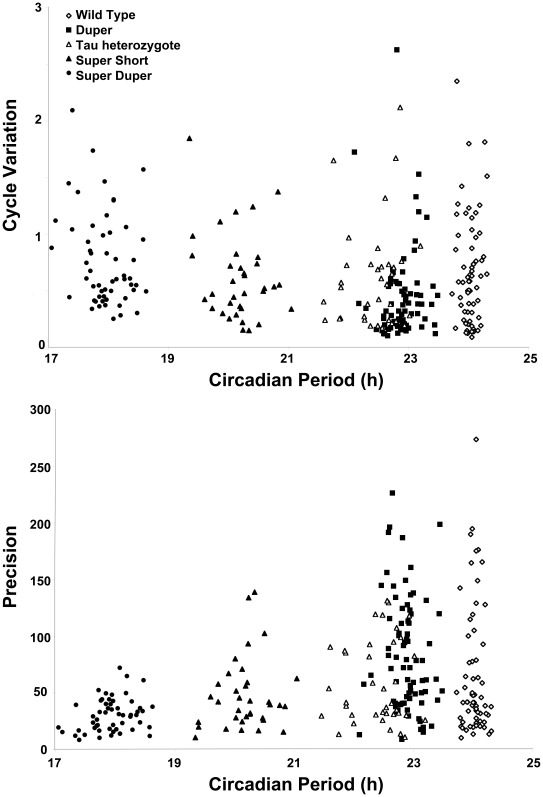
Relationship between τDD, cycle variation and precision in male Syrian hamsters.(A) Scatter diagram depicting standard deviation (in hours) of the mean period of successive activity onsets in individual hamsters. (B) precision (standard deviation normalized to period) in TTDD (diamonds), TTdd (squares), ttDD (filled triangles), TtDD (open triangles), and ttdd hamsters (circles) in the same individuals shown in (A). Neither a linear nor a quadratic fit provides evidence for a minimum cycle variation at a particular τDD value within any of these four genotypes (R2<0.3; P
>0.08). When all genotypes are combined, a weak quadratic trend is statistically significant for both standard deviation (R2 = 0.14, P = 0.02) and precision (R2 = 0.14, P = 0.03).